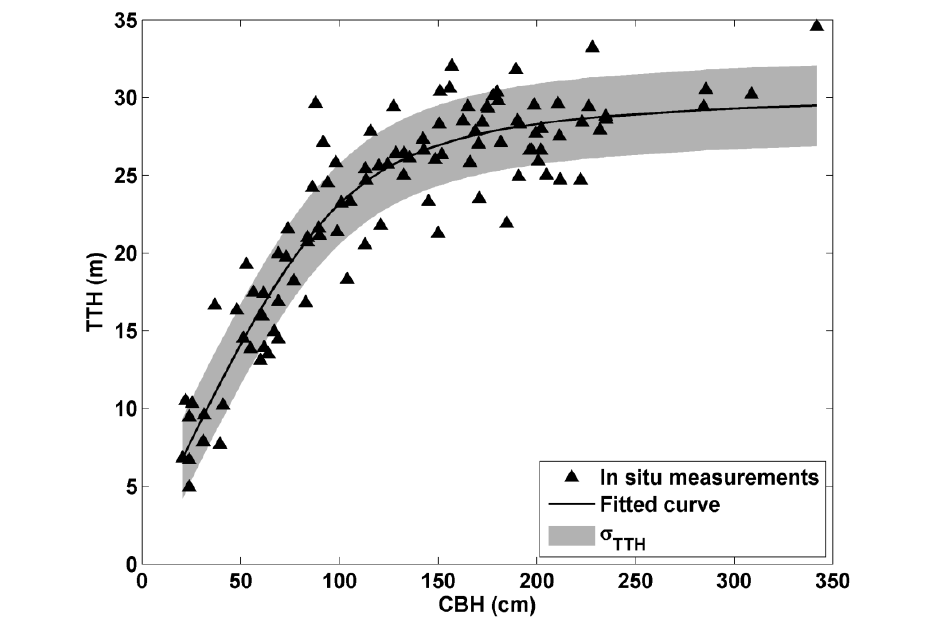
Figure 9. Relationship between the circumference at breast height (CBH) and the tree top height (TTH) for the 105 oaks in the central area of Site 1. The individual measurements are given by triangles; the standard deviation of the fit linked to the uncertainties on field measurements is given by the gray